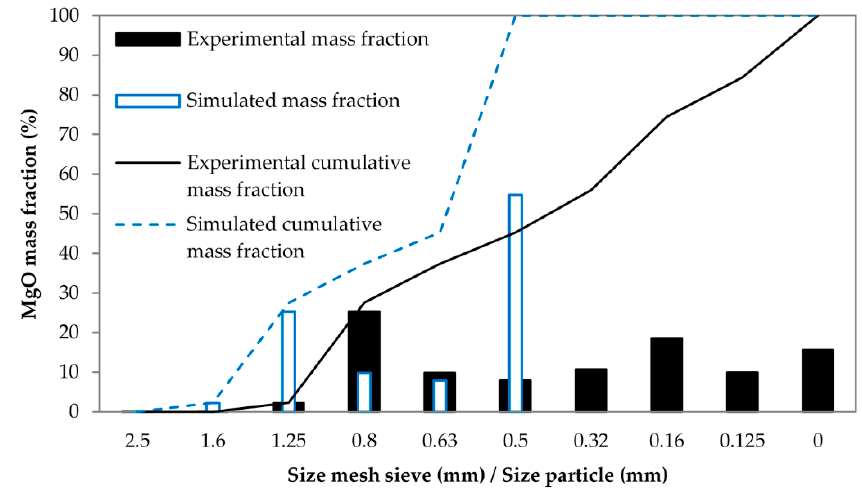
Figure 2. Results obtained in the gradation test for MgO and PSD used in simulations.